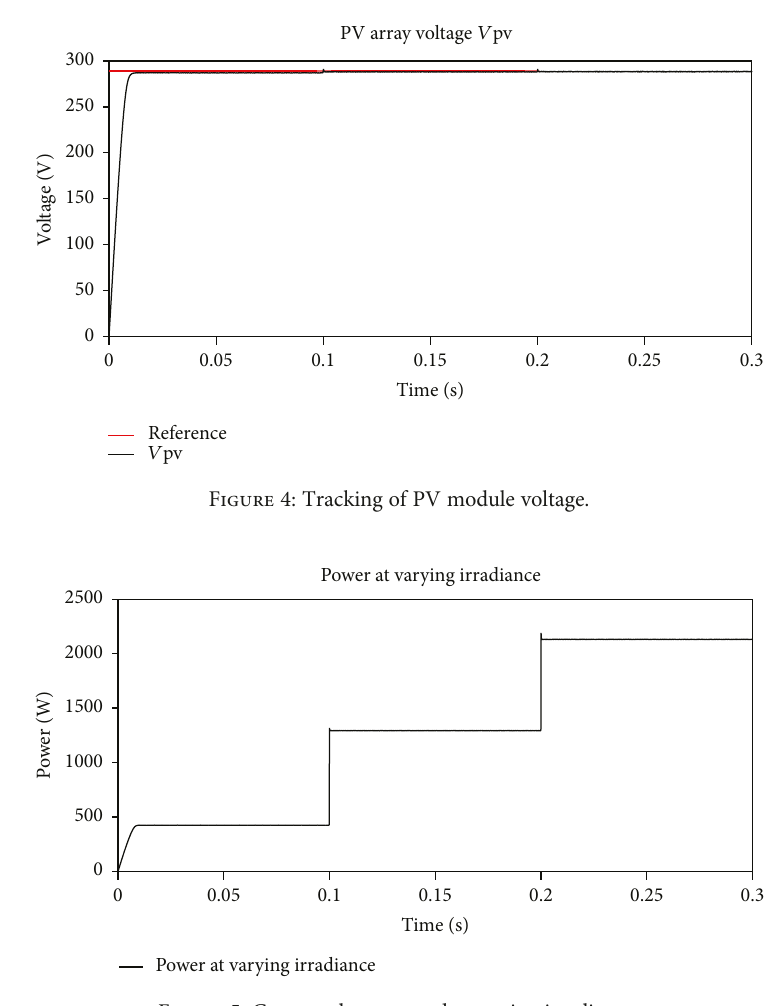
Figure 5: Generated power under varying